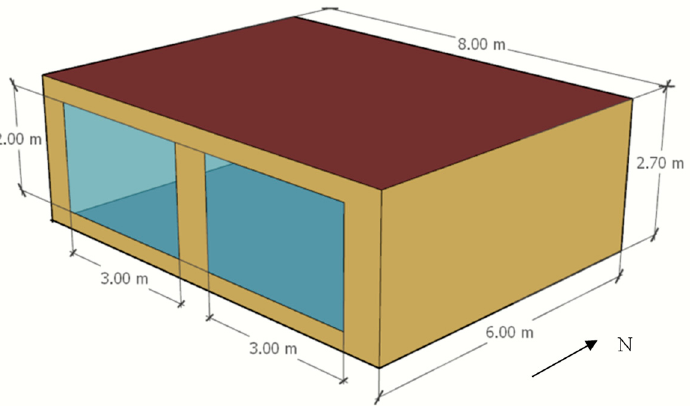
Figure 3. Geometry of the test